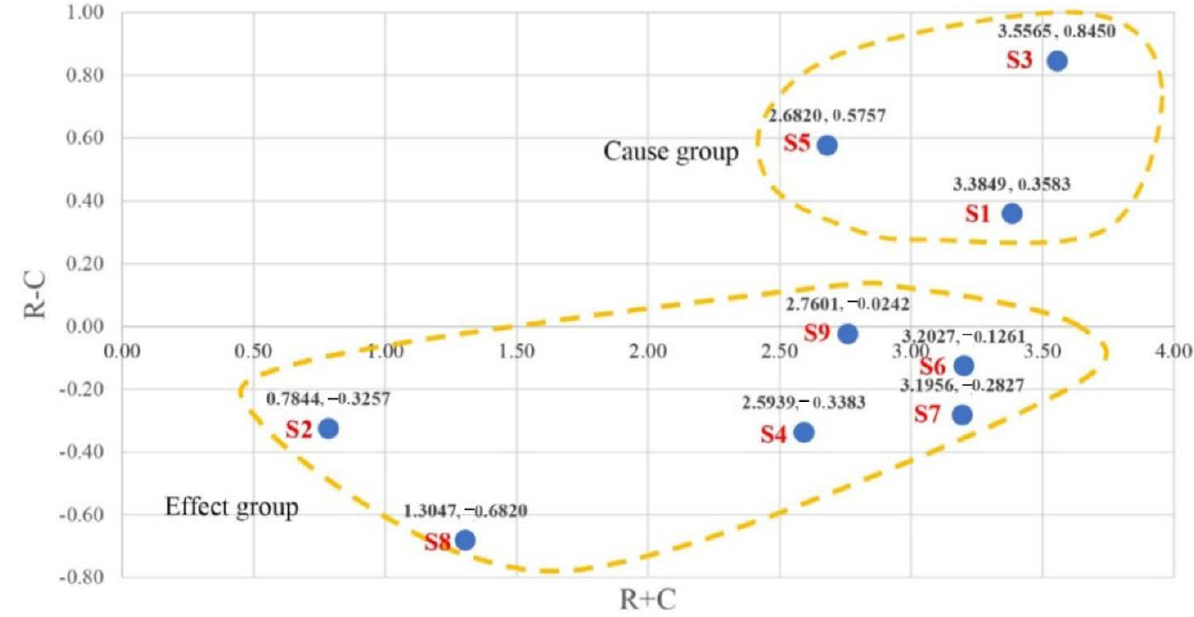
Figure 3. The influence-relations map of the criteria.